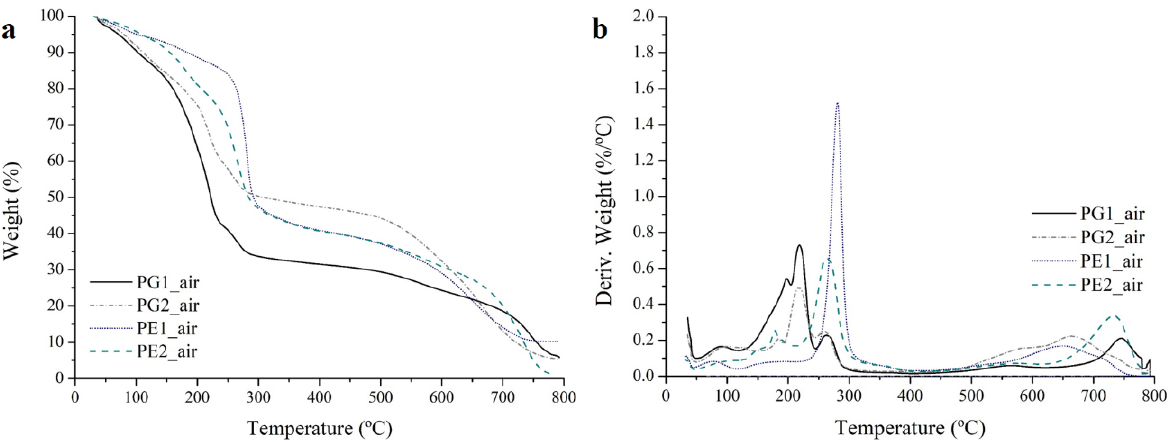
Figure 10. ( a ) TGA and ( b ) DTG data for the different monomers and polymers in air. Table 3. Data obtained from TGA